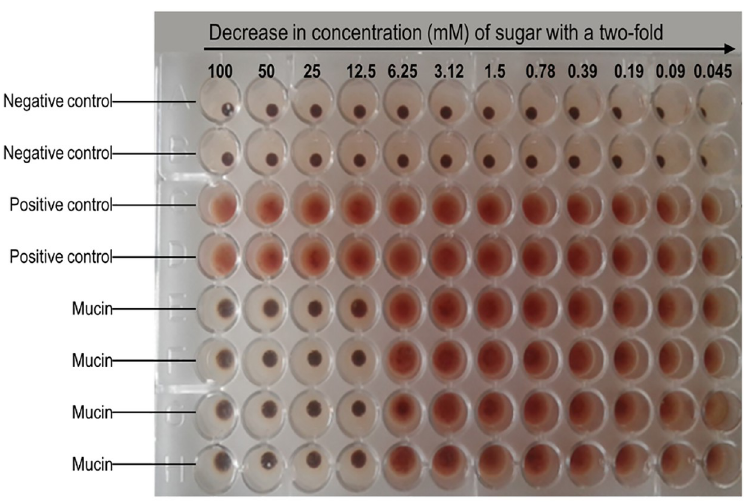
Fig 2. Haemagglutination inhibition assay of B . edulis lectin by porcine mucin. The maximum inhibitory concentration of porcine mucin was 12.5 mM.